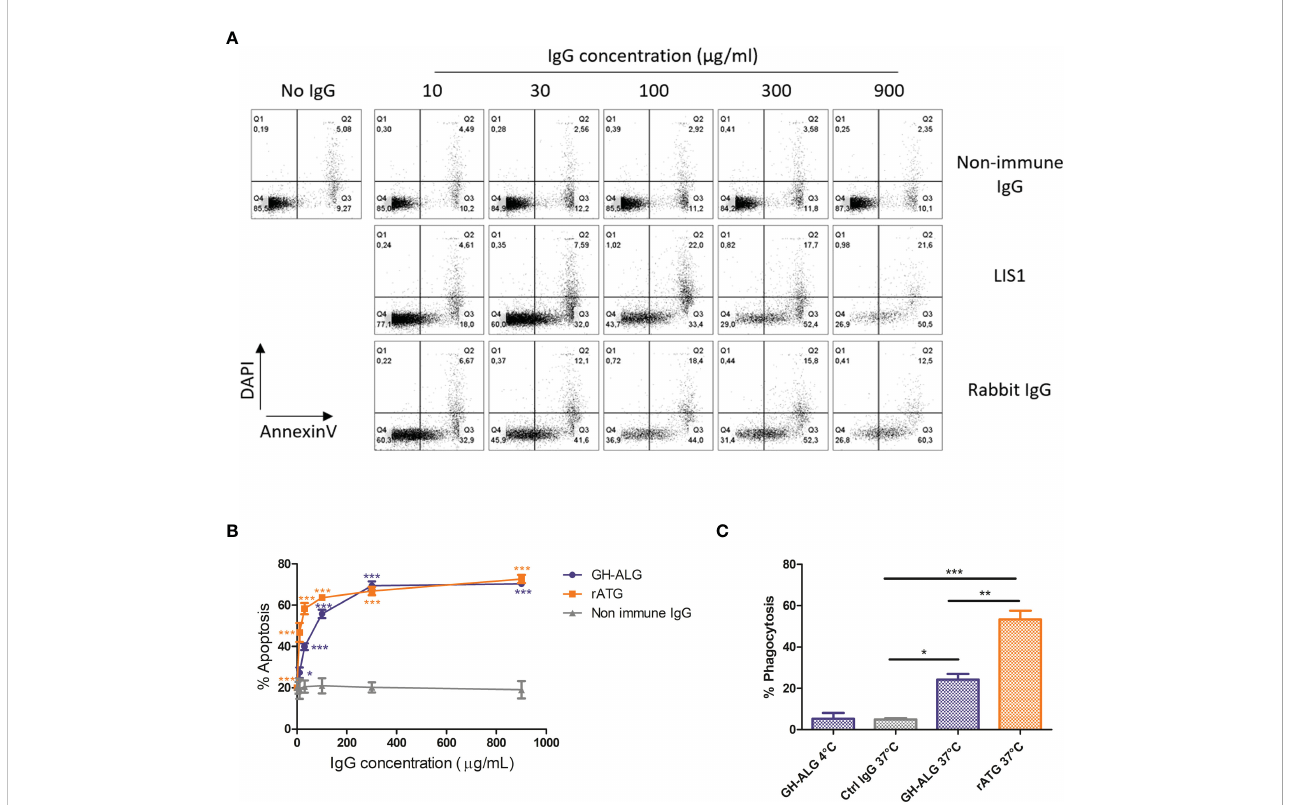
FIGURE 2 Mechanisms of action of GH-ALG. Induction of apoptosis by GH-ALG. (A, B) Human PBMCs were treated with increasing doses (10, 30, 100, 300 and 900 µg/ml) of GH-ALG. Rabbit ATG and nonimmune DKO pig IgG were used as positive and negative controls, respectively. After 3 h of culture (37°C, 5% CO 2 ), apoptosis was monitored by fl ow cytometry by Annexin V and DAPI staining. (B) The mean percentage of apoptosis was then determined by adding the percentage of cells in early (Annexin V+/DAPI-) and late (Annexin V+/DAPI+) apoptosis. The data are expressed as means ± SEM (N=3). Two- way ANOVA (*, p<0.5; **, p<0.01; ***, p<0.005), comparison of GH-ALG or rabbit ATG vs . nonimmune IgG. Phagocytosis assay. (C) Phagocytosis of opsonized PBMCs by human monocyte-derived macrophages was assessed by fl ow cytometry. CFSE-labeled cells were incubated with IgG in RPMI 10% FCS medium for 30 min at 4°C. Lymphocytes were washed twice and cultured with human macrophages (ratio 1:1) in RPMI 10% FCS. After 3 hours of culture, the cells were washed twice, and macrophages were labeled with CD14-BV421 for 30 min at 4°C. Cells were washed twice before fl ow cytometry analysis. Phagocytosis was assessed as the percentage of double ‐ positive (CFSE+/CD14+) cells. The values were compared by ANOVA followed by Tukey ’ s post hoc test. (*, p<0.5; **, p<0.01; ***,